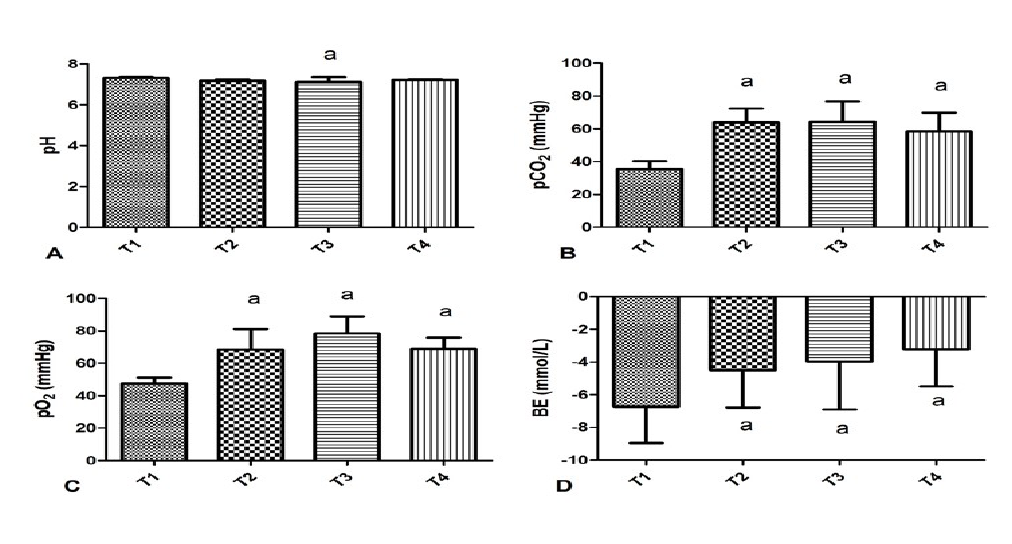
Figure 2. Effects of laparoscopic ovariectomy on blood AB values. A – pH evolution, B – PvCO2 evolution, C – PO2 evolution, D – BE evolution. (mean ± SD) (n = 9) (a = p<0.05 as compared to T1) (T1 = Pre-induction, T2 = control, T3= 30 min of pneumoperitoneum, T4= the end of